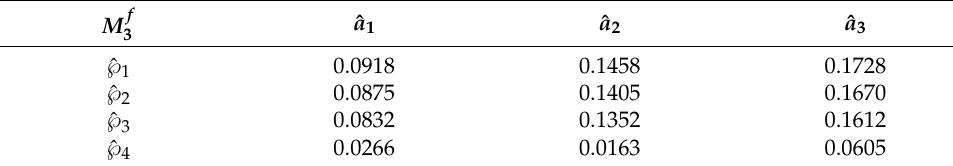
with entries in terms of fuzzy values. 3